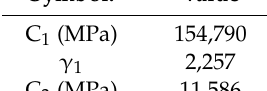
Table 4. Identified material parameters of the force–displacement loop for Cu at 10 N force amplitude.